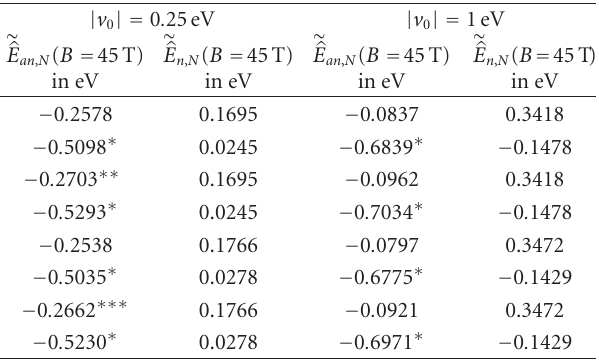
Table 2: The values of the anti-nodal and the nodal excitations for B = 45T for the disorder potential | v | = 0 . 25eV and 1eV. The 0 first four rows correspond to LL index N = 0 while the next four +, E B = 45T) are above the value of to N = 1. All the values of n , N ( μ = − 0 .